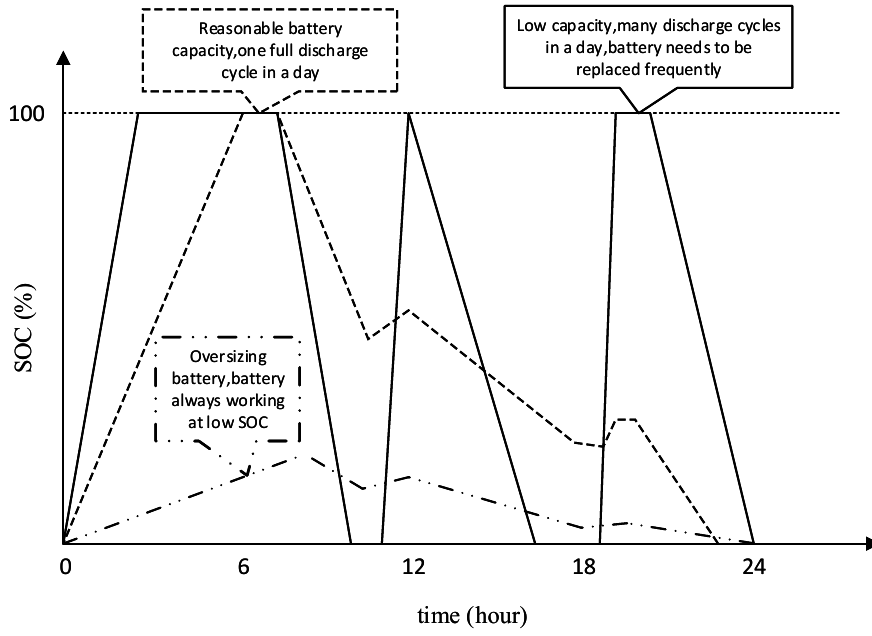
Figure 3. Daily battery SOC curves for different battery capacity levels.